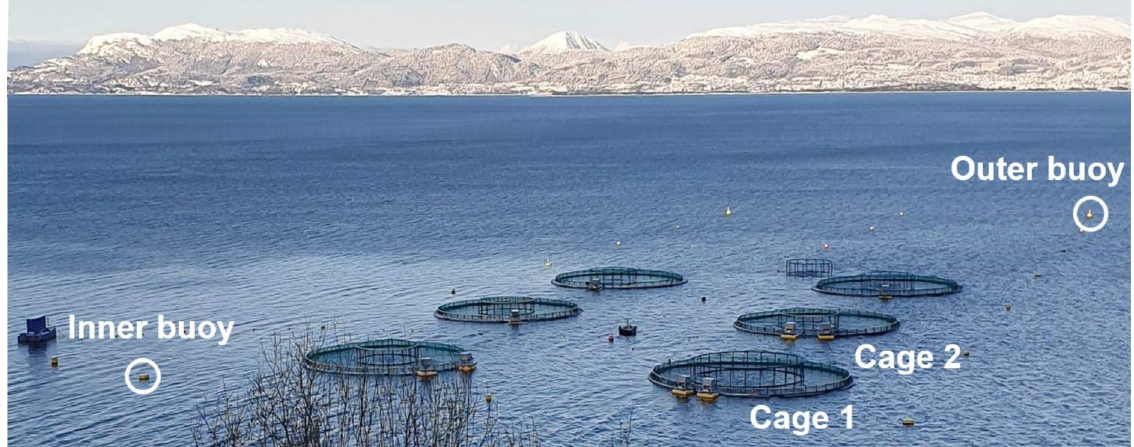
Fig. 2. The 2 sea cages and 2 buoys where video monitoring of wild fish was